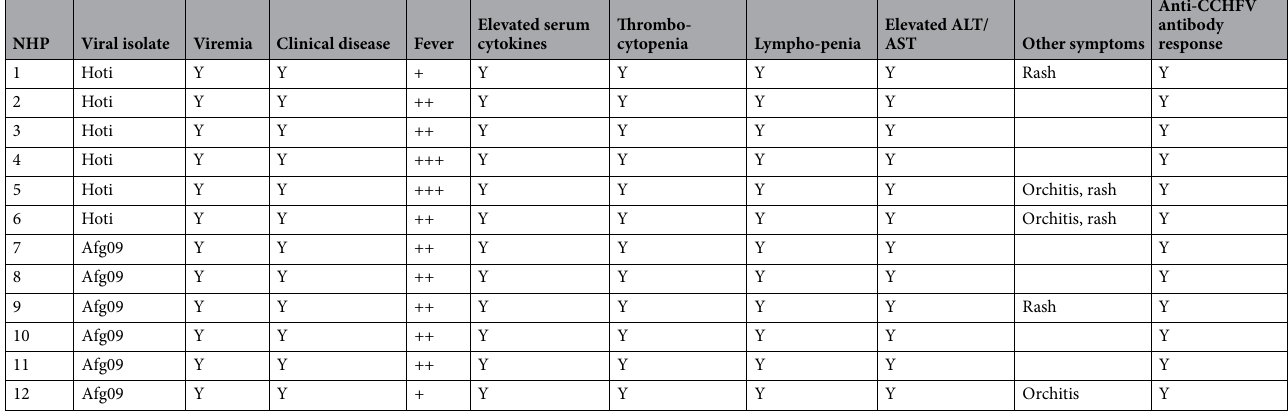
Table 1. Summary of clinical findings from CCHFV Afg09 versus Hoti strain challenge study in cynomolgus macaques. For fever data, 100 h or less of fever above baseline (+), 100–200 h above baseline (++), and 200 h or more above baseline (+++). IgG antibody response measured against both CCHFV Gn and nucleocapsid proteins. Clinical data summarized and reported as previously described in Smith et al. 22